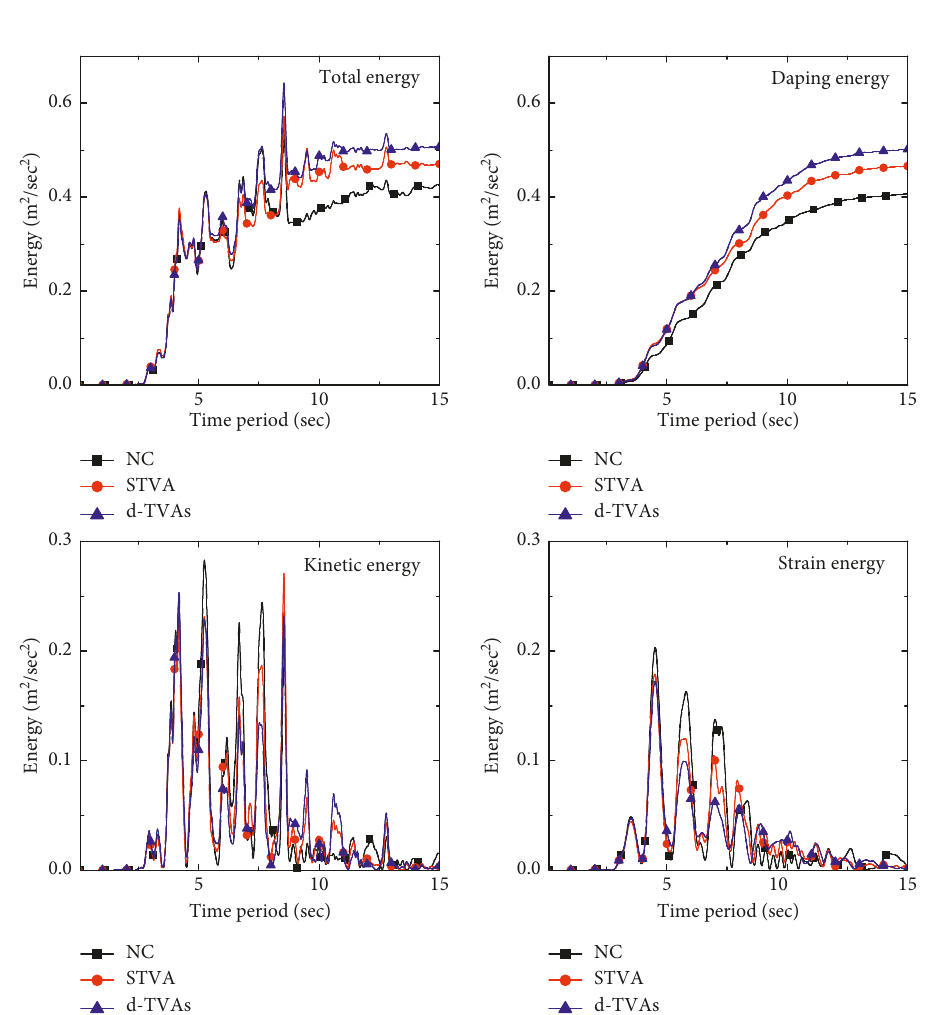
Figure 5: Different energies for the NC, STVA, and d-TVAs subject to Northridge, 1994, ground excitation.